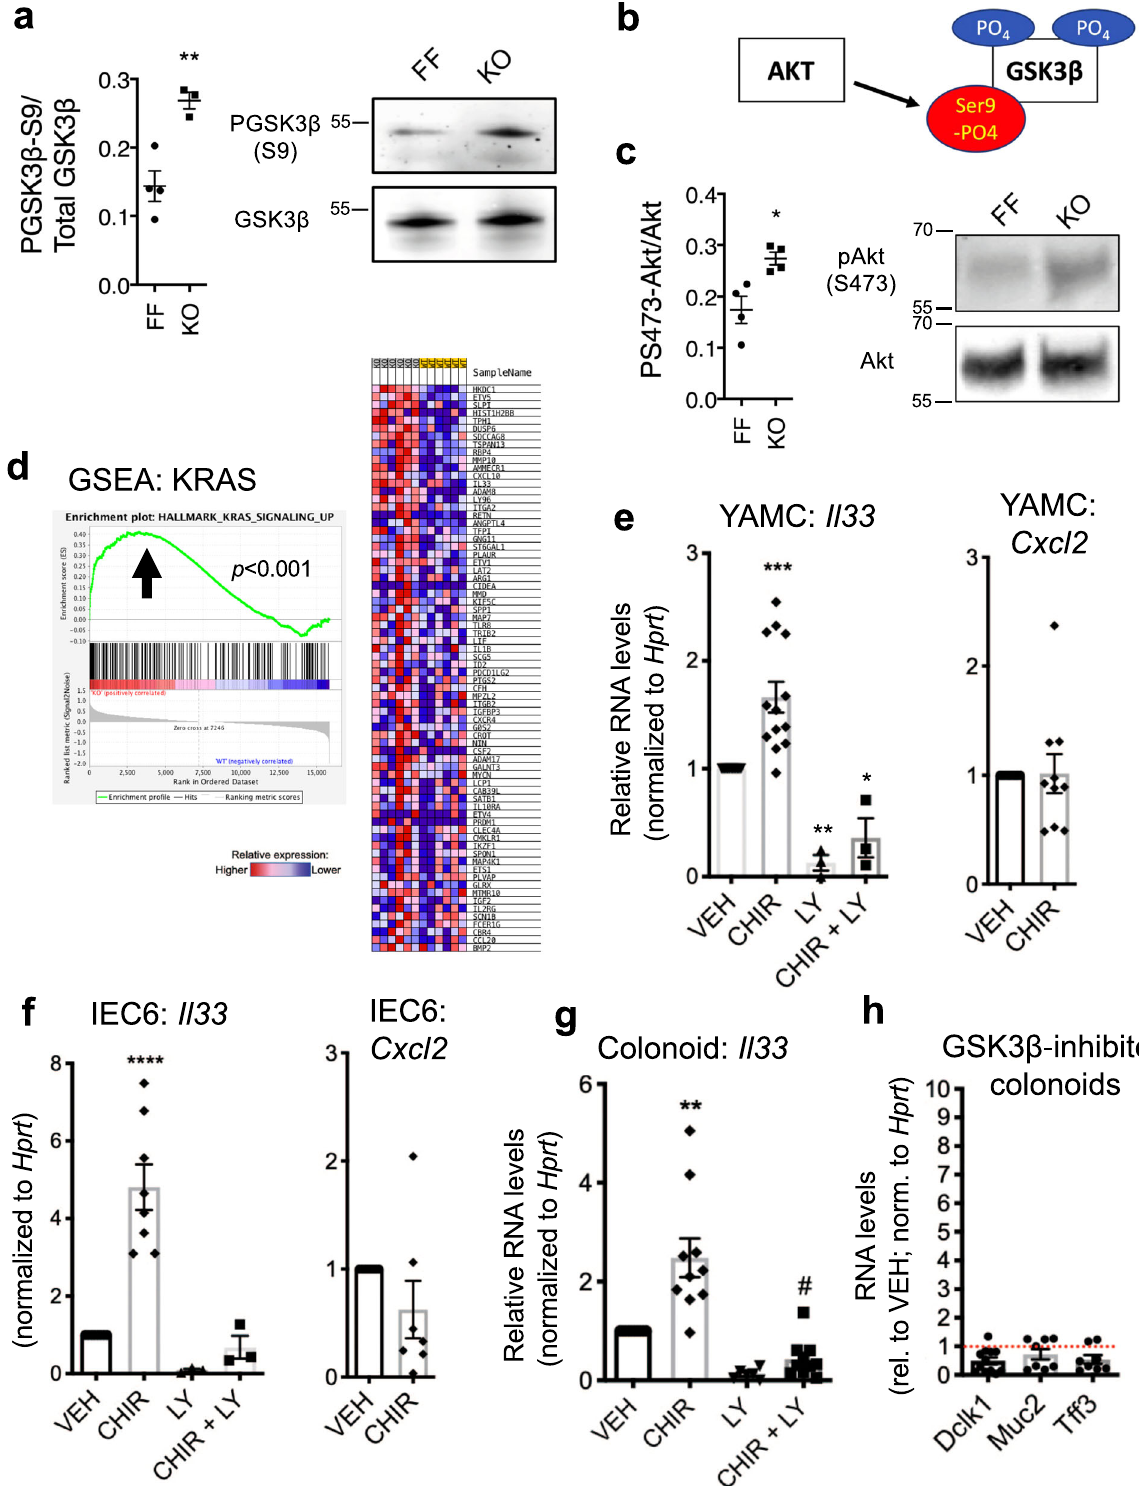
phosphorylation on GSK3 β 38 , we also hypothesized that Sprouty2 loss-driven Il33 induction is through PI3K/Akt. In YAMC and IEC-6 cells, Il33 levels were substantially reduced by PI3K/Akt inhibition (Fig. 6e, f). The same fi ndings on Il33 were observed in primary colon epithelial culture using colonoids (Fig. 6g). Like IL- 33 treatment, GSK3 β inhibition was also unable to induce tuft and goblet cell markers in colonoids (Fig. 6h). Together these data